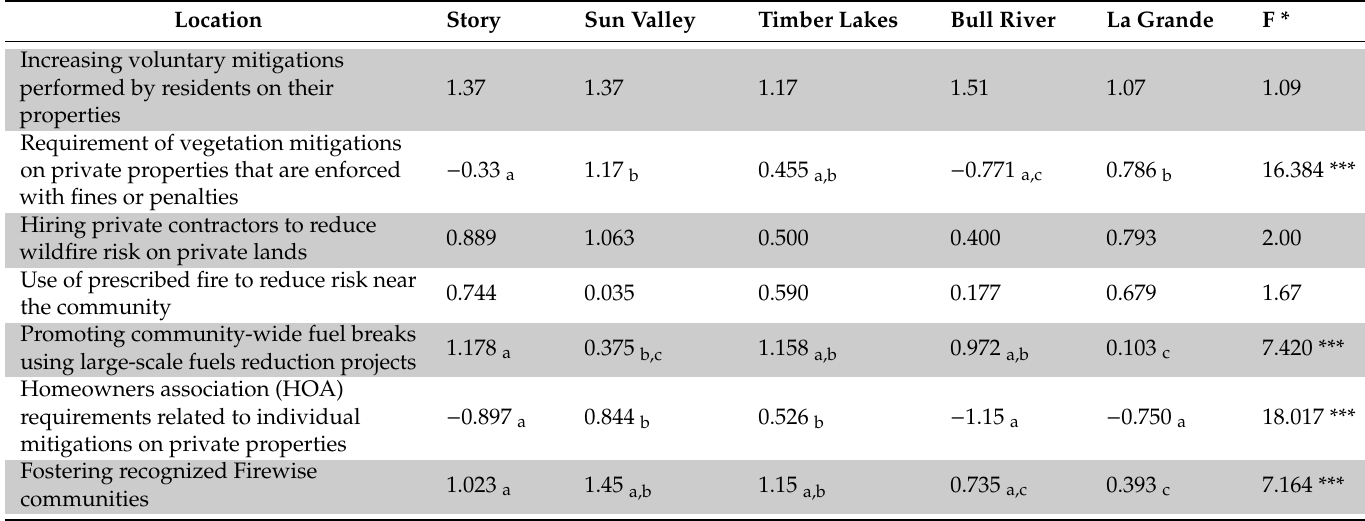
Table 3. Mean ratings of strategy e ff ectiveness or ine ff ectiveness in promoting fire adaptation among participants in case study locations. All ratings were coded with scores ranging from − 2 to